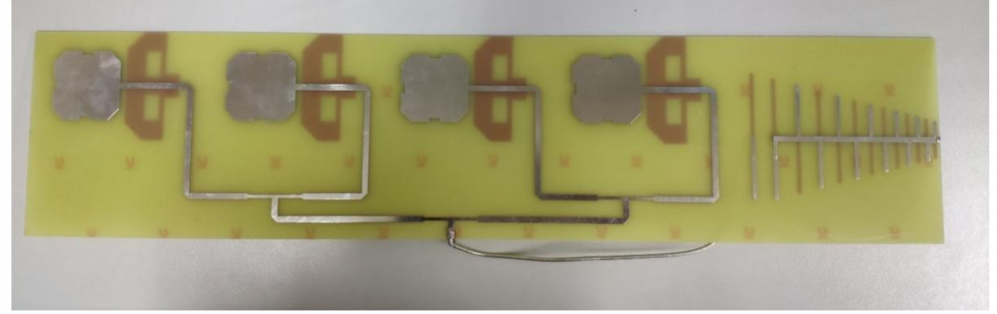
Figure 21. Transceiver module in